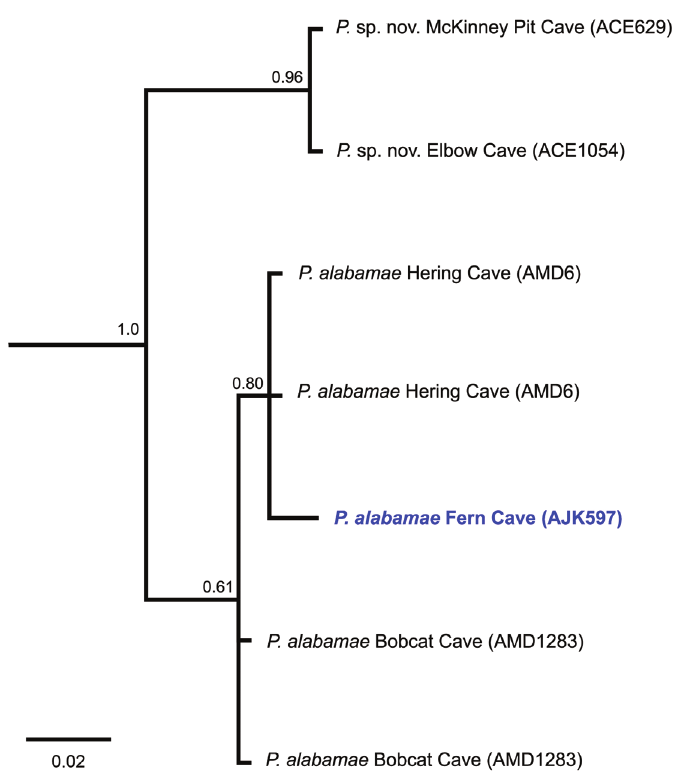
Figure 4. Bayesian phylogram showing the relationships among the new Fern Cave population and other populations of P. alabamae and P. sp. nov. in Alabama inferred from the mitochondrial 16S ribosomal RNA locus. Posterior probabilities are to the left of the corresponding